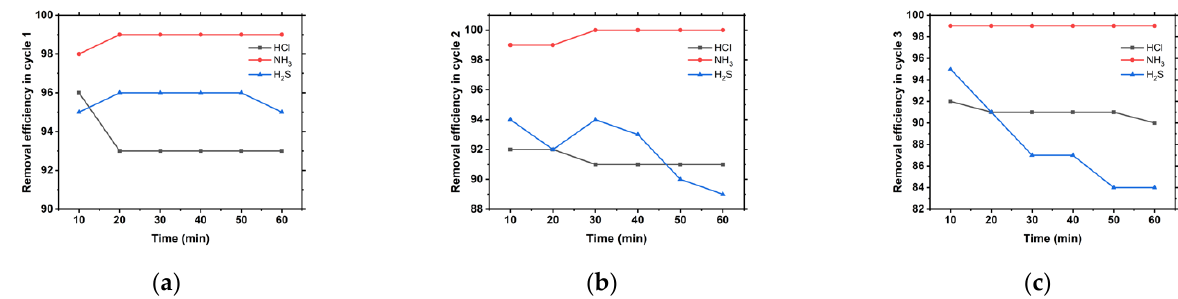
Figure 3. The contaminant removal efficiency in the carbonation stage at 650 °C for the first ( a ), the second ( b ), and the third cycle ( c ).